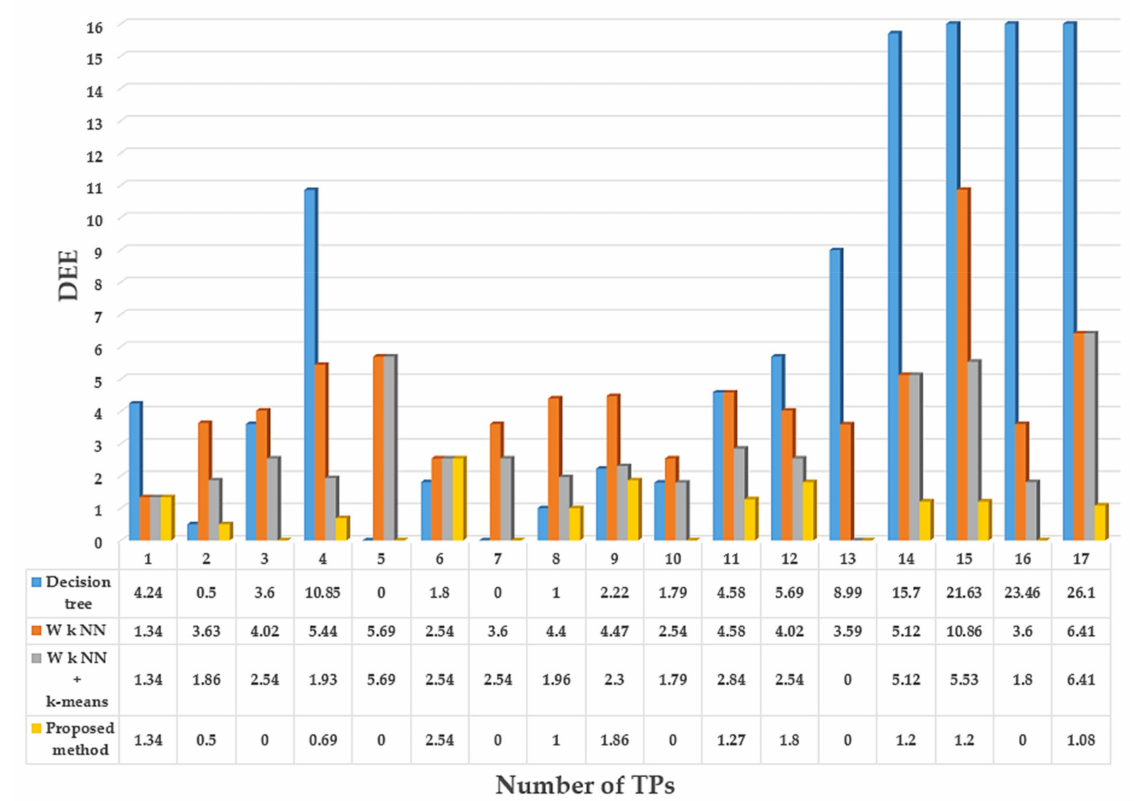
Figure 10. Distance estimation error comparison in meters. Estimated user location of traditional methods and the proposed method.